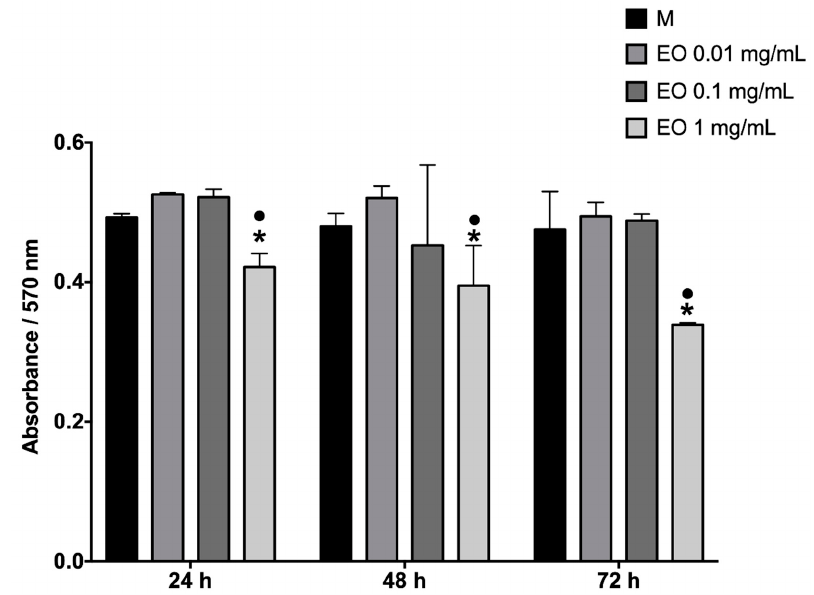
Figure 9. Cell proliferation assay of monolayer cultures. Resazurin absorbance indicated the proliferation of fibroblasts with absorbance control with medium plus Tween. The stimuli applied: M: DMEM media supplemented; EO 0.01 mg/mL; EO 0.1 mg/mL, and EO 1 mg/mL. *Significant di ff erences with respect to M. ● Signi fi cant di ff erences with respect to EO 0.01 ( p < 0.05). Molecules 2020 , 25 , x